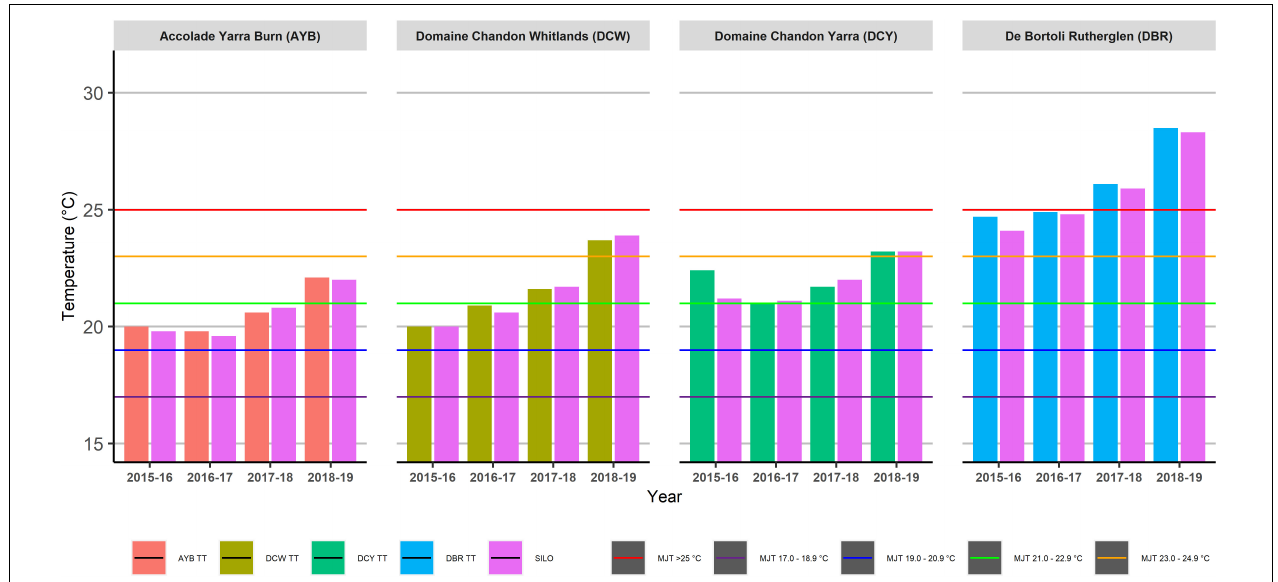
FIGURE 7 | Mean January Temperature (MJT) across four sites and four seasons as calculated using Tinytag (TT) or Scientific Information for Landowners (SILO) data.